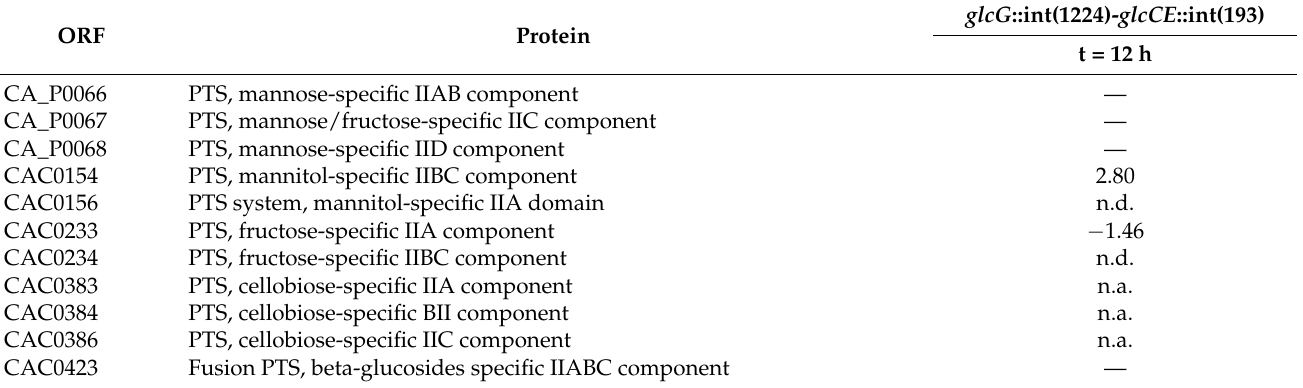
Table 2. Transcriptional profiles of all the PTS enzyme II protein genes of mutant C.